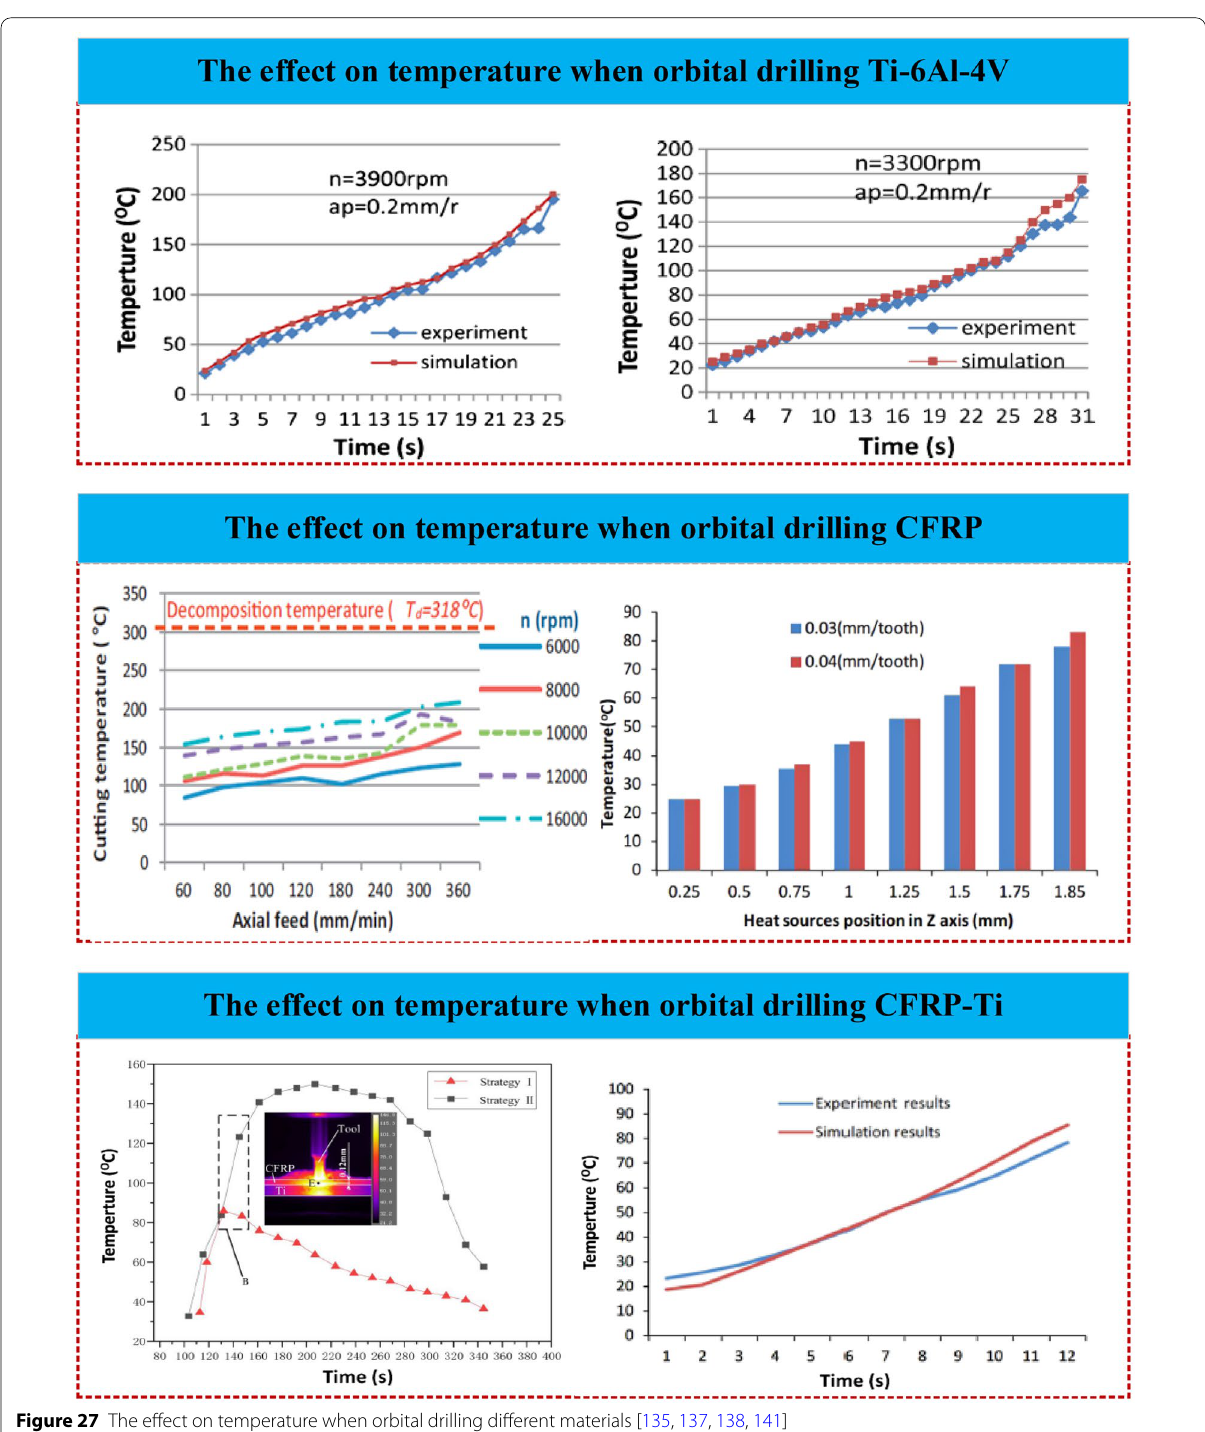
Figure 27 The effect on temperature when orbital drilling different materials [135, 137, 138,